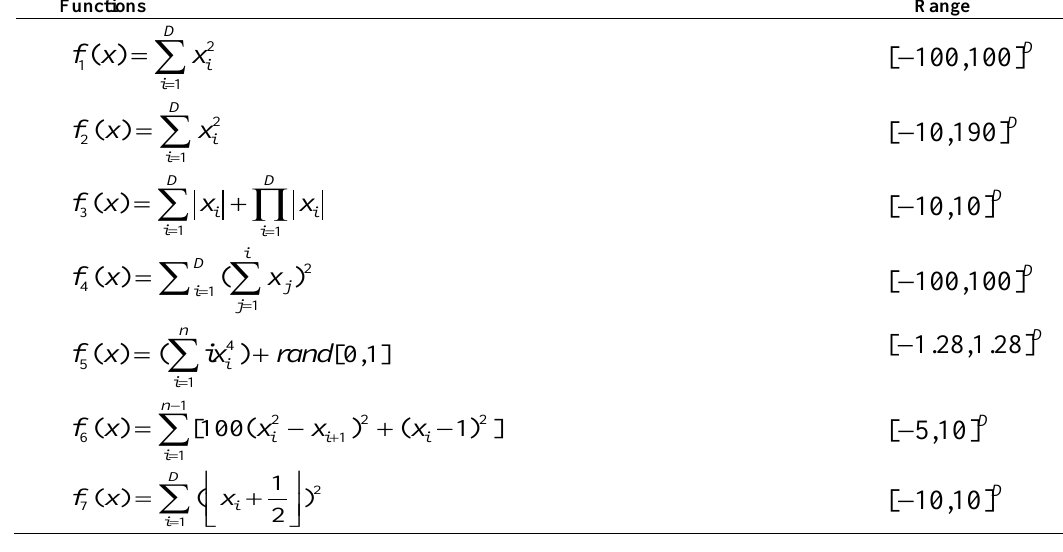
Table 2. Multimodal test functions ( D = 30 in this work). Functions